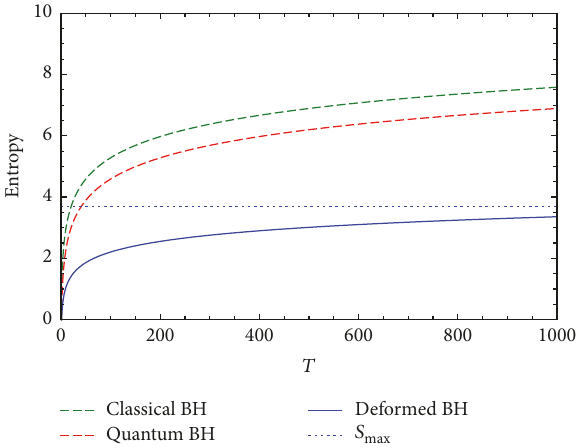
Figure 1: Entropy of quantum black hole versus temperature for 𝑚 = ℎ = 𝐸 = 𝜆 = 1 . As we have obtained this result in [23– 𝑝 25], in high energy limits and near the Plank length scale, the effects of quantum gravity can be considered as a perturbation sentence in quantum mechanical theory which leads to reducing the photon radiation from the distant observer’s point of view. So, black holes in quantum gravity frameworks have numerically smaller entropy than the nondeformed black holes in four